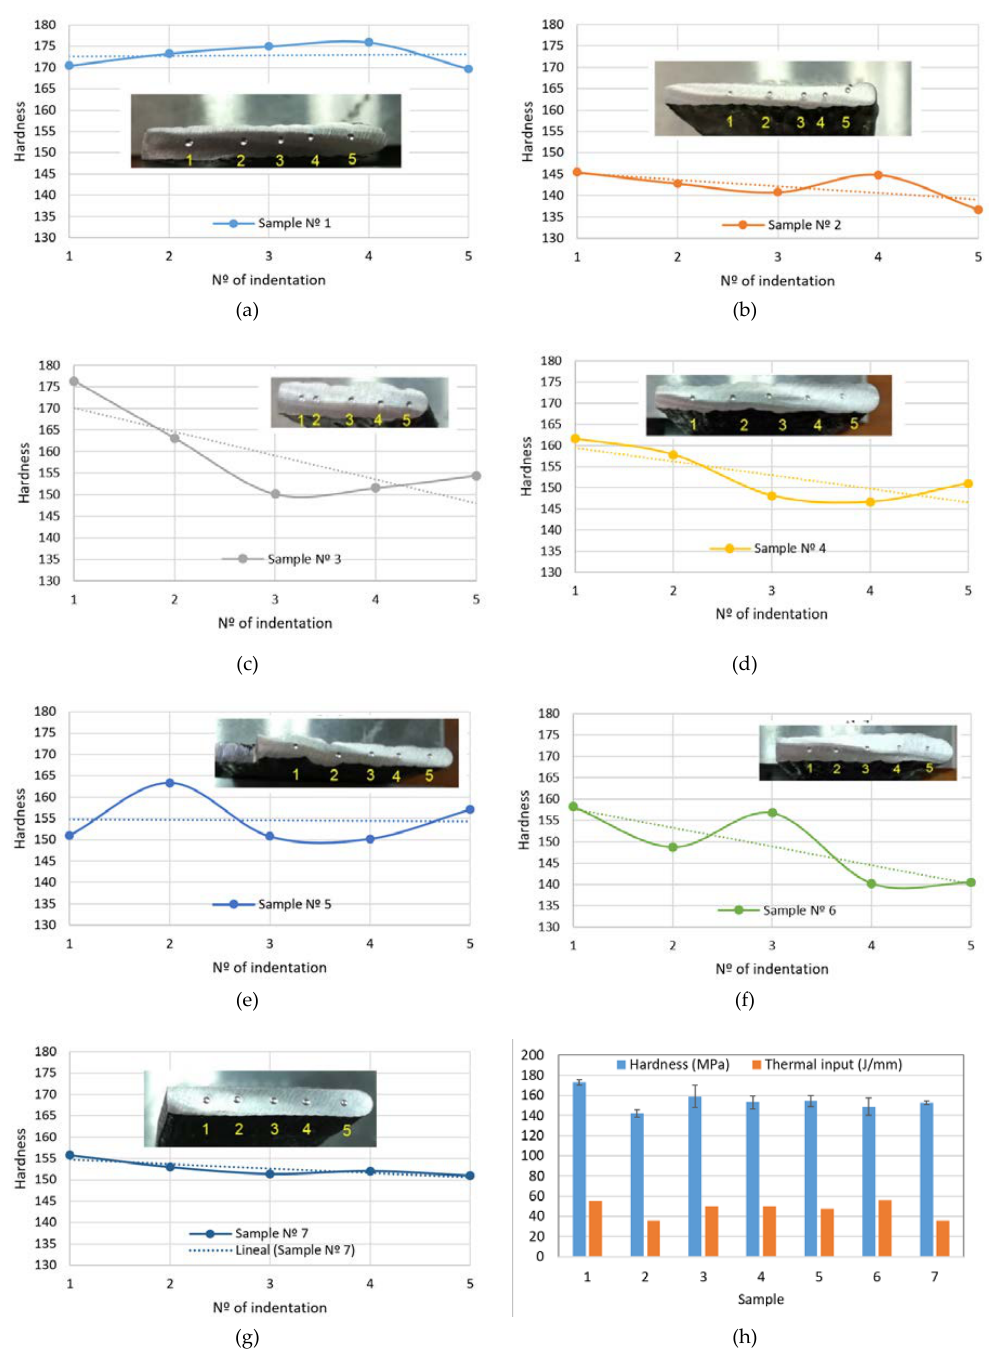
Figure 6. Brinell hardness profiles for the WAAM samples: ( a ) Sample nº 1, MIG (conventional); ( b ) Sample nº 2, CMT process; ( c ) Sample nº 3, CMT Adv. pol. 0; ( d ) Sample nº 4, CMT Adv. pol. 0; ( e )